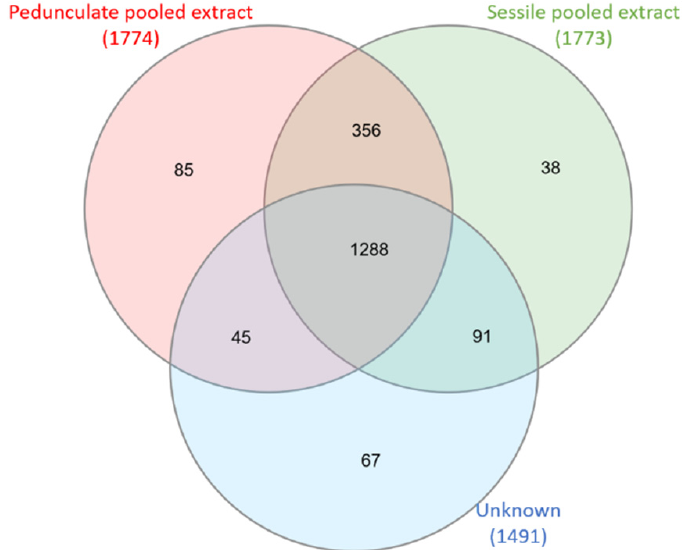
Figure 5. Venn diagram of an unknown individual sample (1 sample) attributed sessile compared to sessile pooled extracts (21 samples) and pedunculate pooled extracts (21 samples). Numbers above species represent total precursor ions detected in each extract. The circle overlap represents common ions, and the non-overlapping part represents specific ions. The individual (in blue) is well distributed within the sessile pool and the pedunculate pool in the common clusters (1 to 7) described in Table 1. The individual is not present